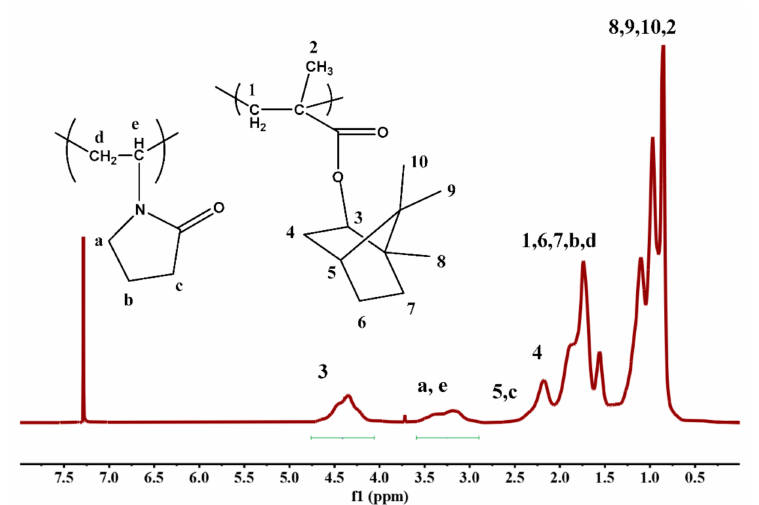
Figure 2. 1 H-NMR spectrum of the sample F60/40 in CDCl 3